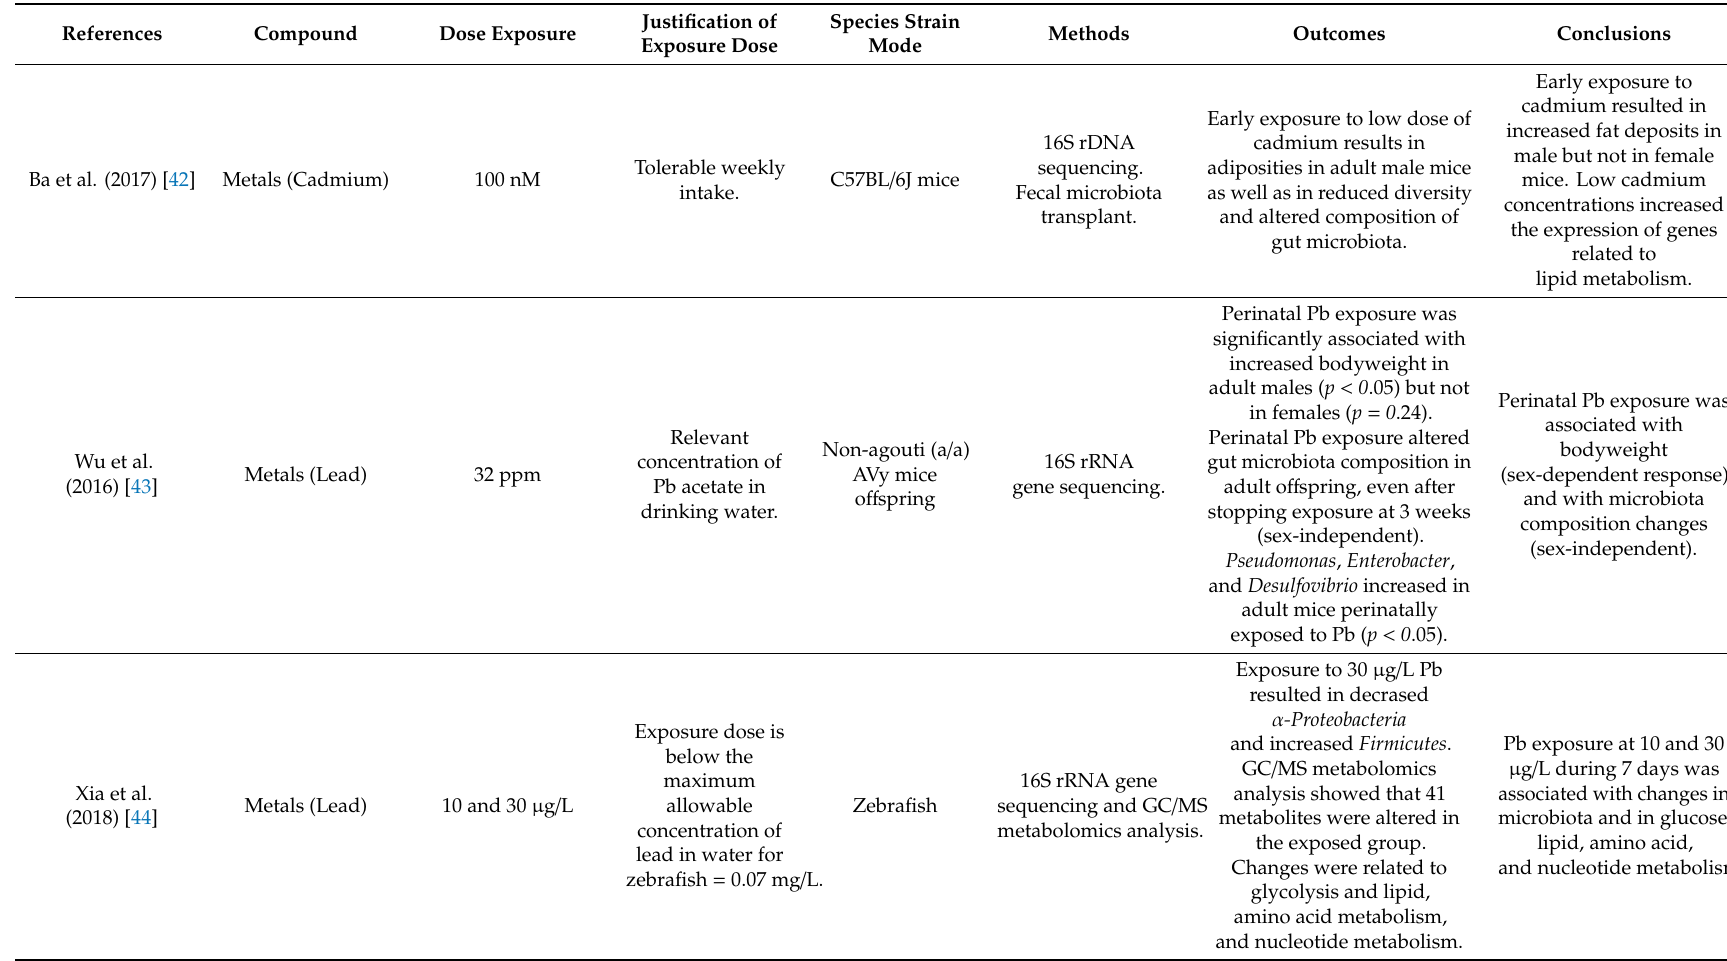
Table 2. E ff ects of endocrine disruptors on the animal